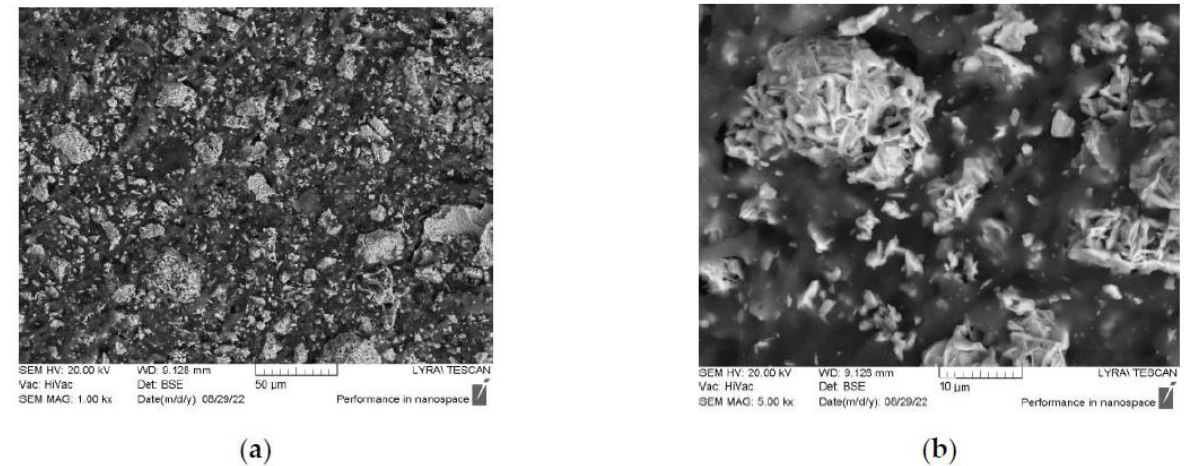
Figure 1. SEM images of ( a ) sample P1A and ( b ) zoomed area of a cluster.